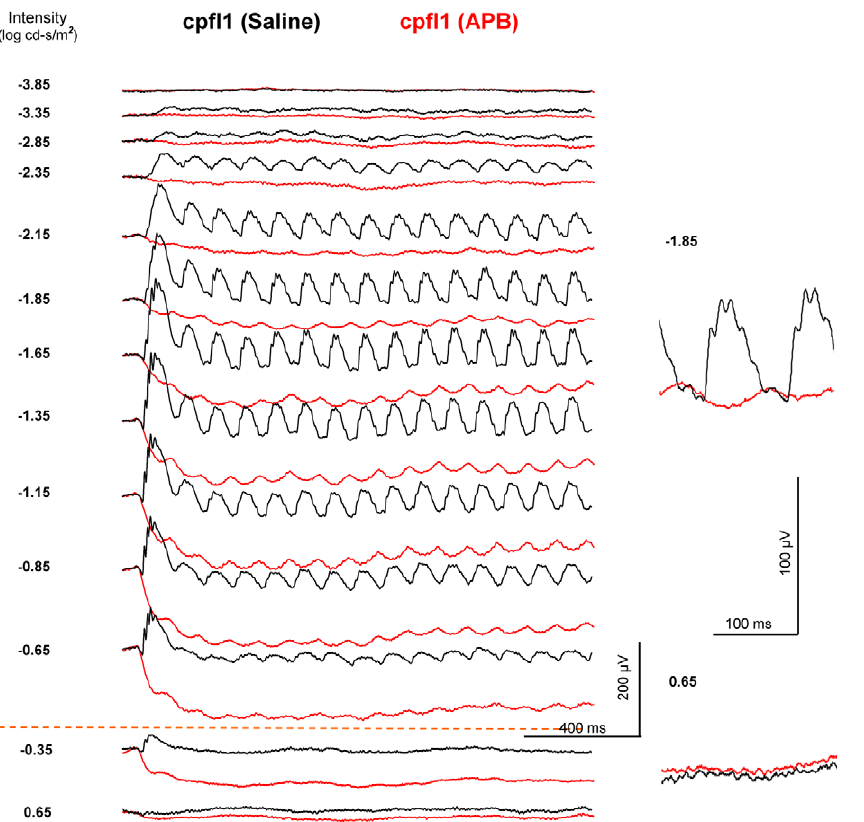
Figure 9. The effect of the ON-channel blocker APB on the dark-adapted 10-Hz flicker ERG of a cpfl1 mouse. The black traces show ERGs of the saline-injected control eye and the red traces show ERGs of the APB-injected contralateral eye. The threshold of flicker ERG response increases and the amplitude decreases in the APB-injected eye. The dark-adapted 10-Hz flicker ERG responses exist at the medium intensities ( 2 2.15 , 2 0.65 log cd-s/m 2 ), but are absent at high